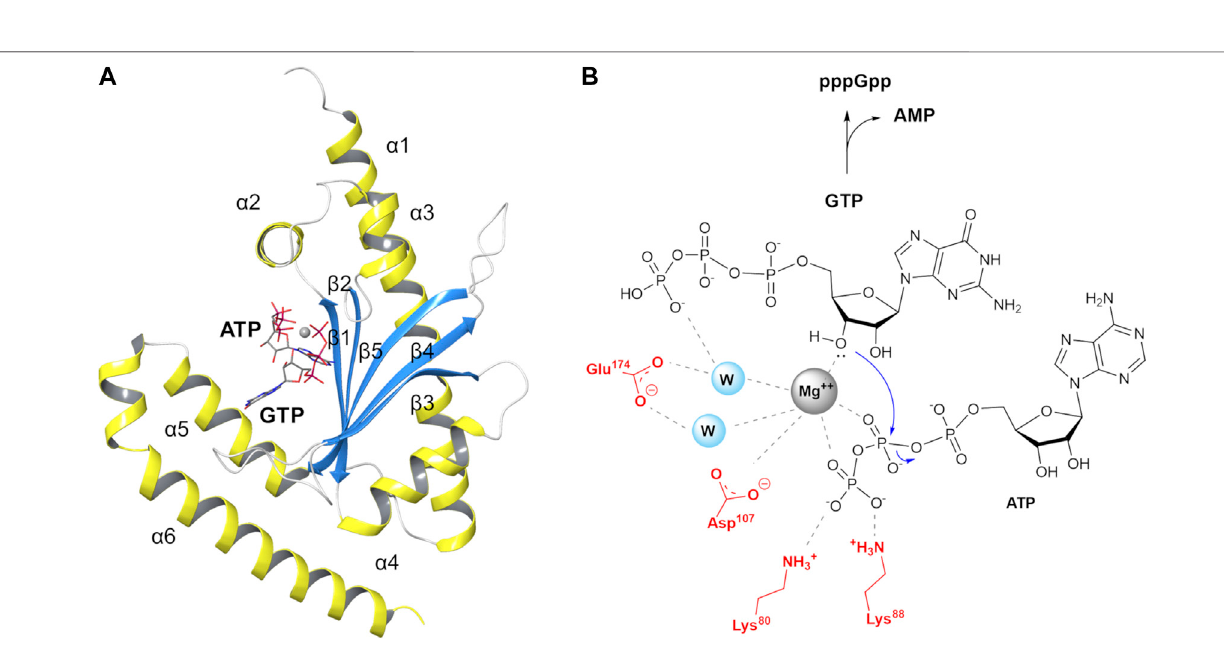
Frontiers in Molecular Biosciences |